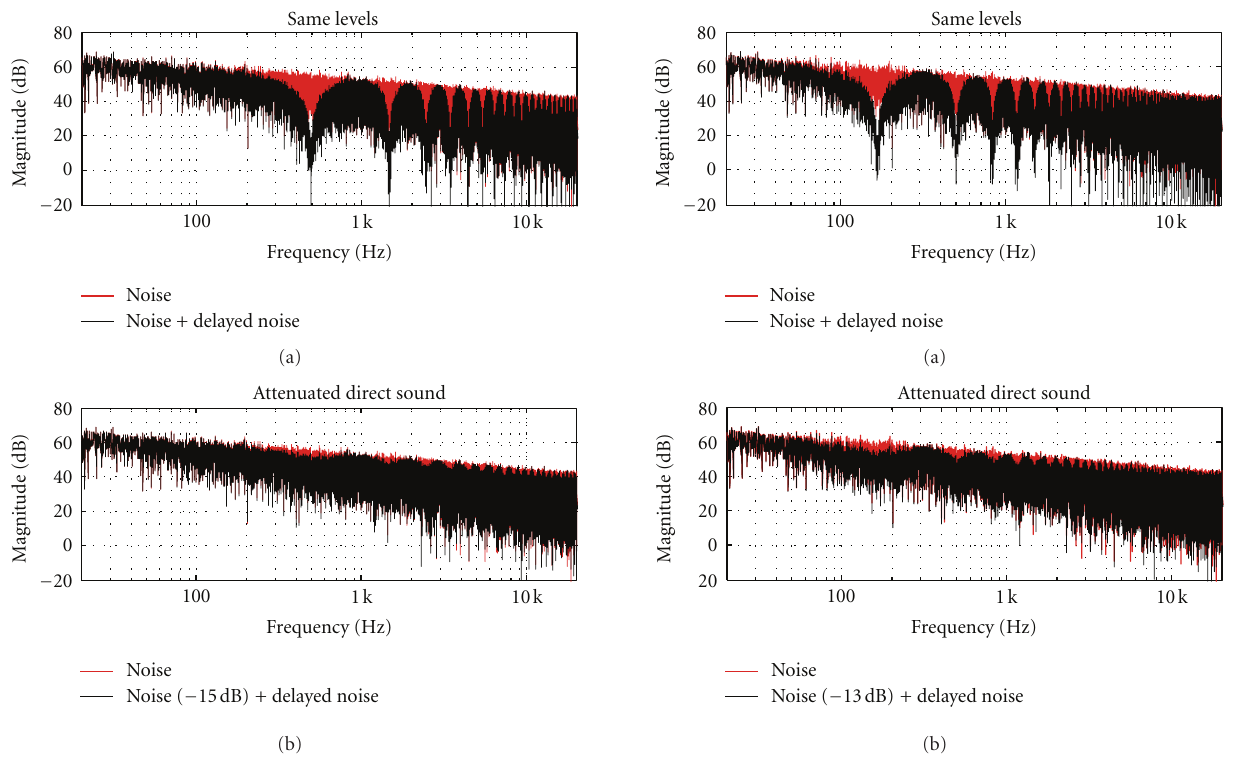
Figure 17: Comb filtering e ff ect with the delay of 1ms. The red curve represent the spectrum of pink noise and the black curve represents the spectrum of pink noise which is added to the delayed version of itself. (a) illustrates the comb filtering e ff ect, when the added signals have the same energy, whereas (b) illustrates the e ff ect when the passive attenuation of the ARA headset is considered.